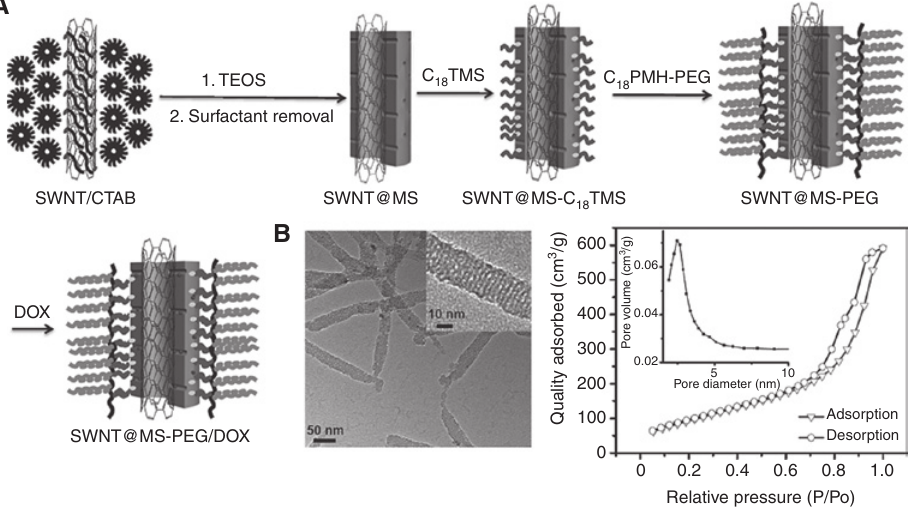
Figure 5: (A) Synthetic route to SWCNT@MS-MEG showing the preparation of mesoporous silica, its pegylation, and addition of CNT to con- struct the complete SWCNT@MS-MEG. (B) TEM image of the nanoparticles before pegylation. (C) Illustration of desorption and adsorption of cargo and its corresponding pore size. Reused from Reference [67] with permission of John Wiley and Sons’